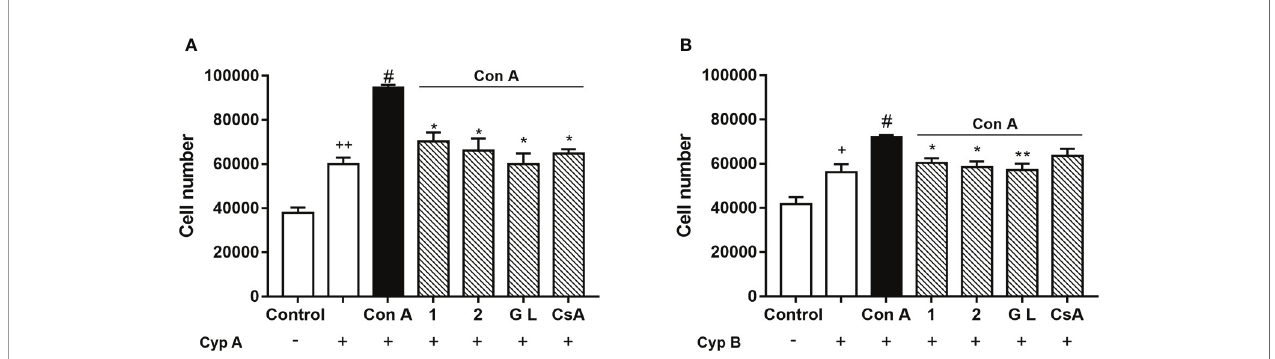
FIGURE 5 | Effect of compounds 1 , 2 , and GraL over human T lymphocytes migration. Cells were pre-treated with compound 1 , 2 (0.1 µM), GraL (1 m M) or CsA (0.2 µM) for 2 h and then were stimulated with Con A (50 m g/mL) for 48 h. Then, T cells were placed in the migration chamber for 24 hours in the presence of the chemoattractant CypA (50 ng/mL) (A) or CypB (5 ng/mL) (B) . Controls of untreated T cells in the presence or absence of Cyps are also included. Data are the result of average ± SEM (n = 3). The values are shown as the difference between Con A migratory cell numbers compared to cells treated with compounds plus Con A, * p < 0.05 and ** p < 0.01. Values of cells treated with Con A were compared with cells in the presence of CypA or B, # p < 0.05. Values of untreated cells in absence of CypA or B were compared with untreated cells in presence of CypA and B, + p < 0.05 or ++ p < 0.01. One-way ANOVA test with Dunnet ’ s post hoc analysis and Student´s t-test were used for statistical